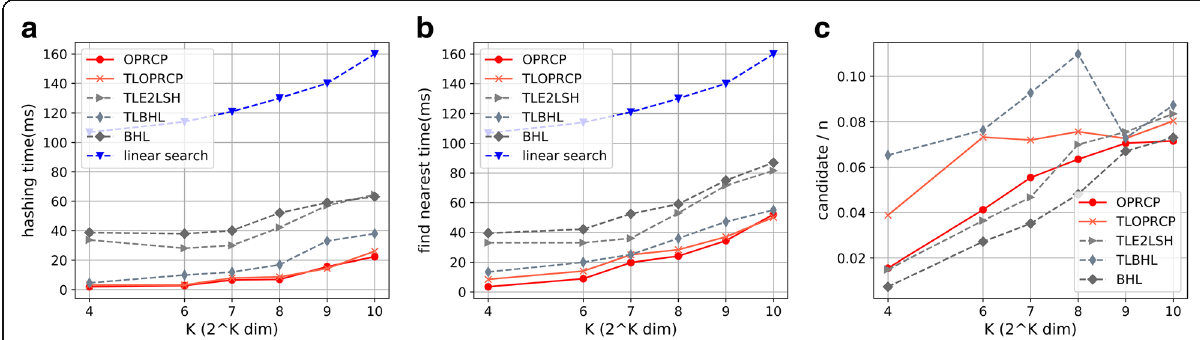
Fig. 7 Comparison of algorithms in different dimensional data-1. a k versus the hashing time between different methods. b k versus the find nearest time between different methods. c k versus the rate of candidates between different